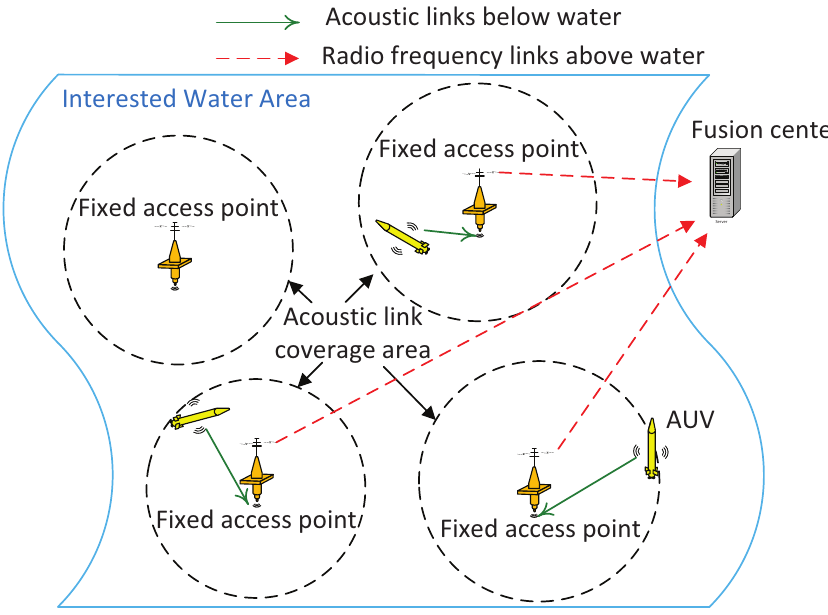
Figure 1. An illustration of the system layout with three autonomous underwater vehicles (AUVs) and four access